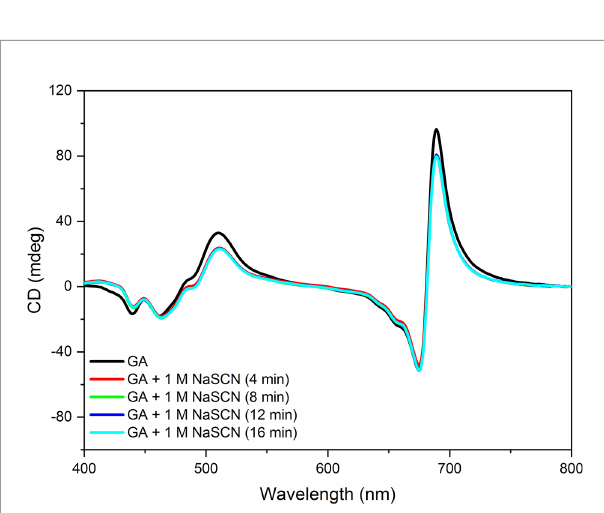
FIGURE 4 | CD spectra of isolated pea thylakoid membranes in the absence (control) and presence of 2 M Hofmeister-salt combinations composed of NaCl and NaSCN — with constant Na + concentration and different concentrations of Cl - and (SCN) - , as indicated. The spectra were recorded 20 min after the treatments. The spectra are normalized to the corresponding red absorbance maxima [OD(680 nm)=1.0] of the untreated samples. Three independent biological replicates were measured and a typical data set is shown.